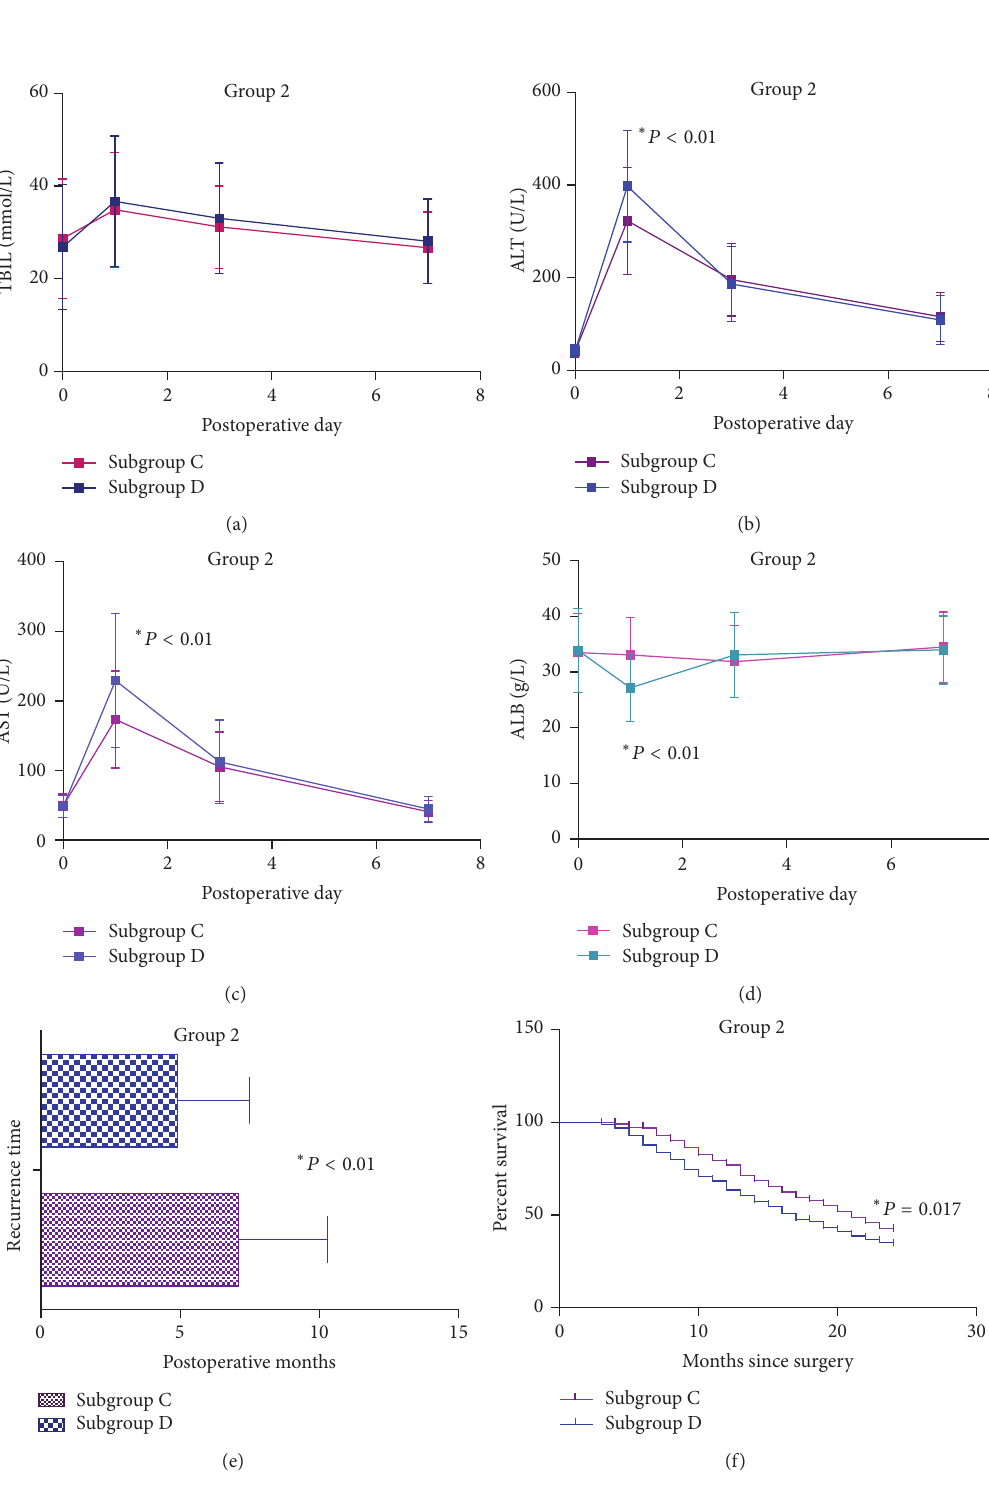
Figure 3: Curves of parametric data for patients in group 2 during the perioperative period and prognosis data. (a) Curves of TBIL levels in group 2 on postoperative days 1, 3, and 7. (b) Curves of ALT levels in group 2 on postoperative days 1, 3, and 7. (c) Curves of AST levels in group 2 on postoperative days 1, 3, and 7. (d) Curves of ALB levels in group 2 on postoperative days 1, 3, and 7. (e) Recurrence time of patients in group 2. (f) Cumulative survival of all included patients in group 2 in the first 24 postoperative